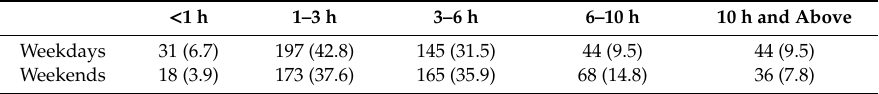
Table 2. Screen time of students majoring in design on weekdays and